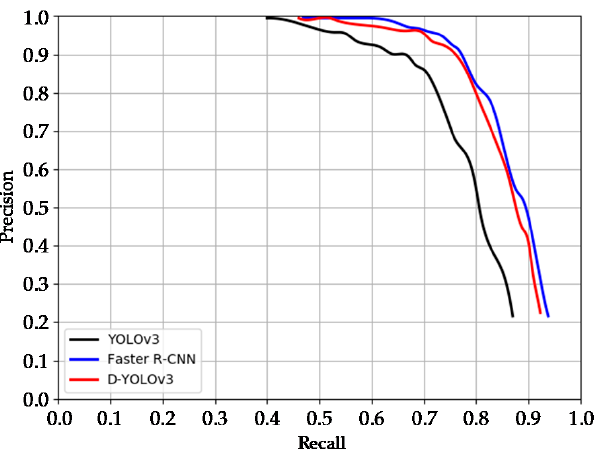
Figure 10. Precision-Recall(P-R)curves.